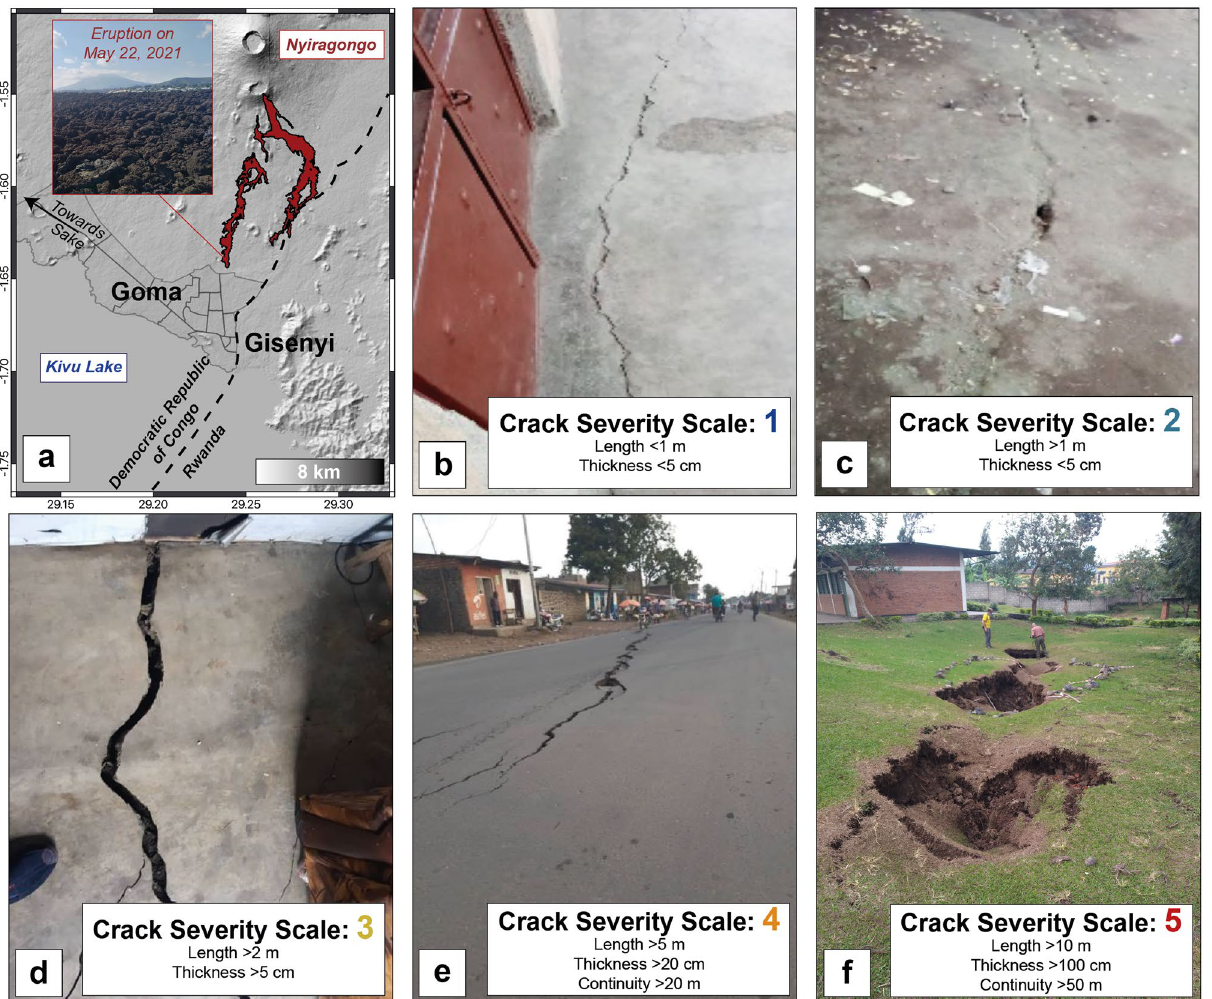
Figure 1. ( a ) Location map of the Nyiragongo volcano, the lava flows from the May 22, 2021 eruption (estimated volume not exceeding 10 Mm 3 with respect to the minimum volume of 16 Mm 3 estimated in the lava lake in 2020 9 ; Burgi, pers. comm.), and the cities of Goma and Gisenyi. ( b – f ) Photos and severity index of the cracks across Goma and Gisenyi. Credits Attribution: Esri, USGS, ESA/CNES. Pictures from the